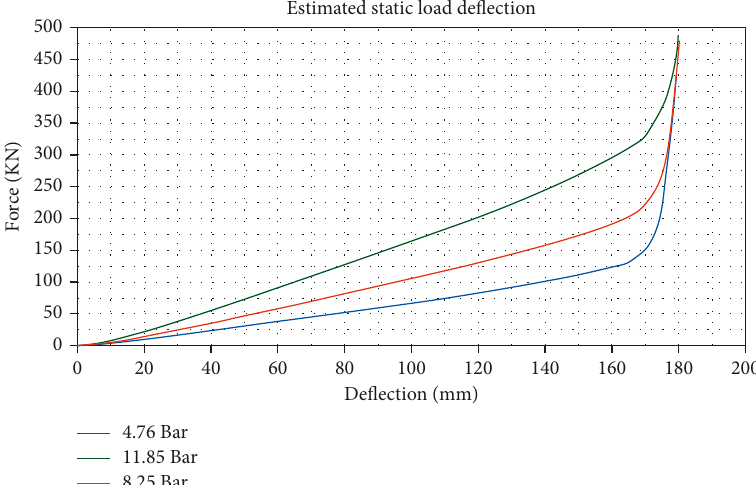
Figure 27: Numerical vertical forces vs. tyre displacement curves as a function of the tyre